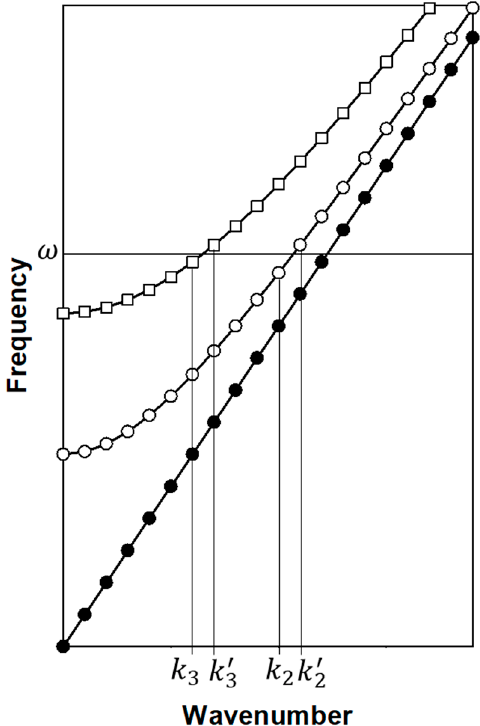
Figure 2. Schematic illustration of the band structure of the three coupled one-dimensional elastic waveguides. 𝜔 is the frequency of the external driving force. The wavenumbers of the states with the largest amplitudes along the two bands with cut-off frequencies are labelled on the wavenumber axis.